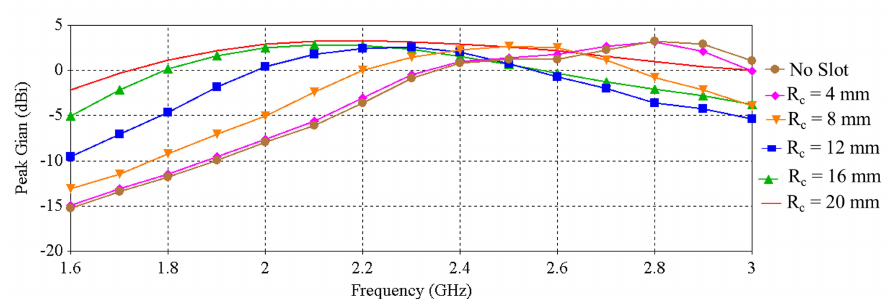
Figure 4. Peak gain vs. frequency when varying the radius of the slot of the ground plane.